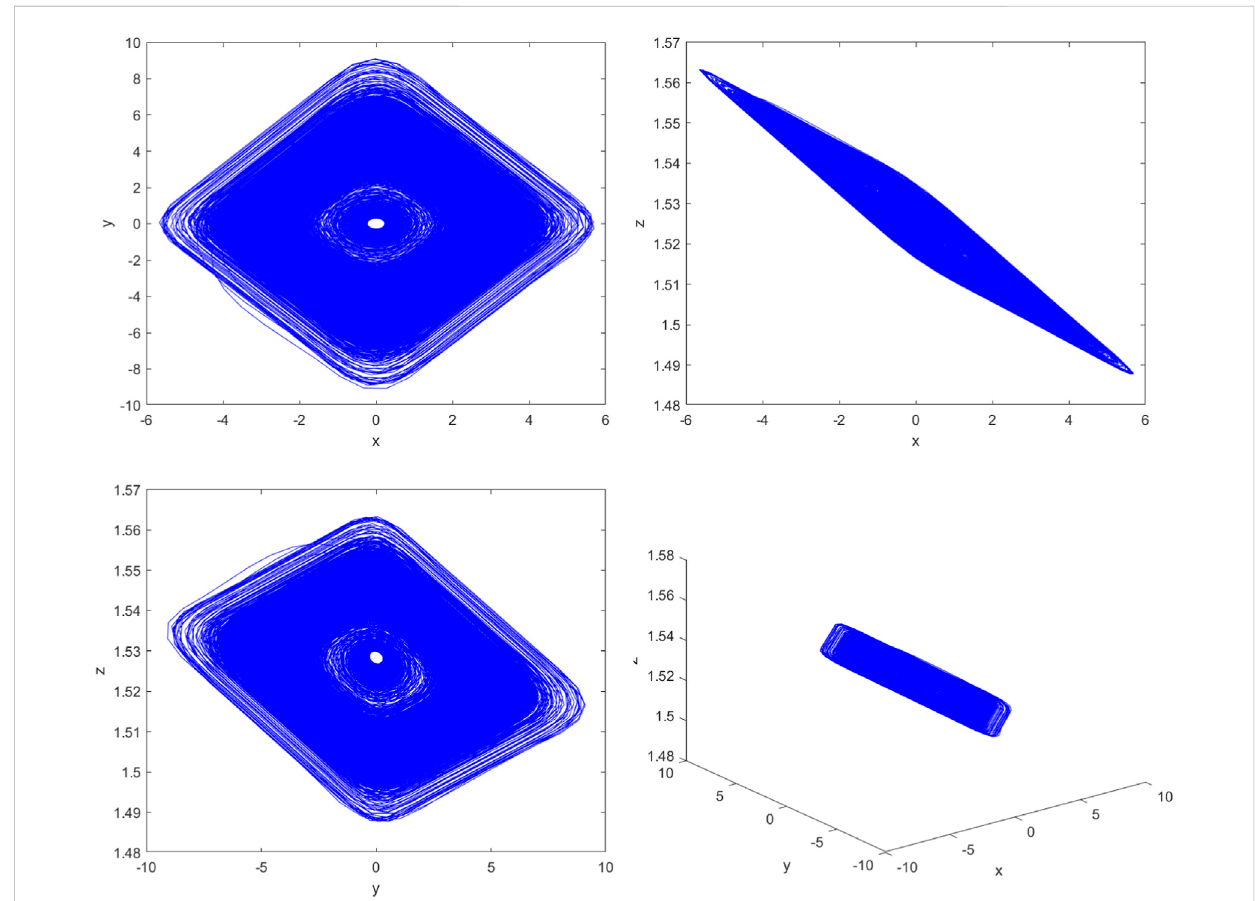
FIGURE 1 Phase diagrams of the chaotic Hop fi eld neural network